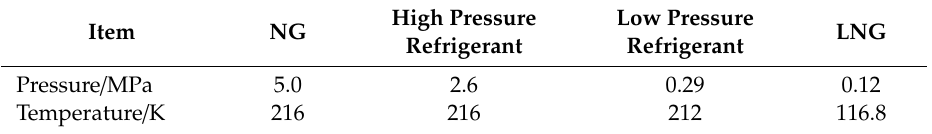
Table 2. Natural gas (NG) liquefaction process initial data.